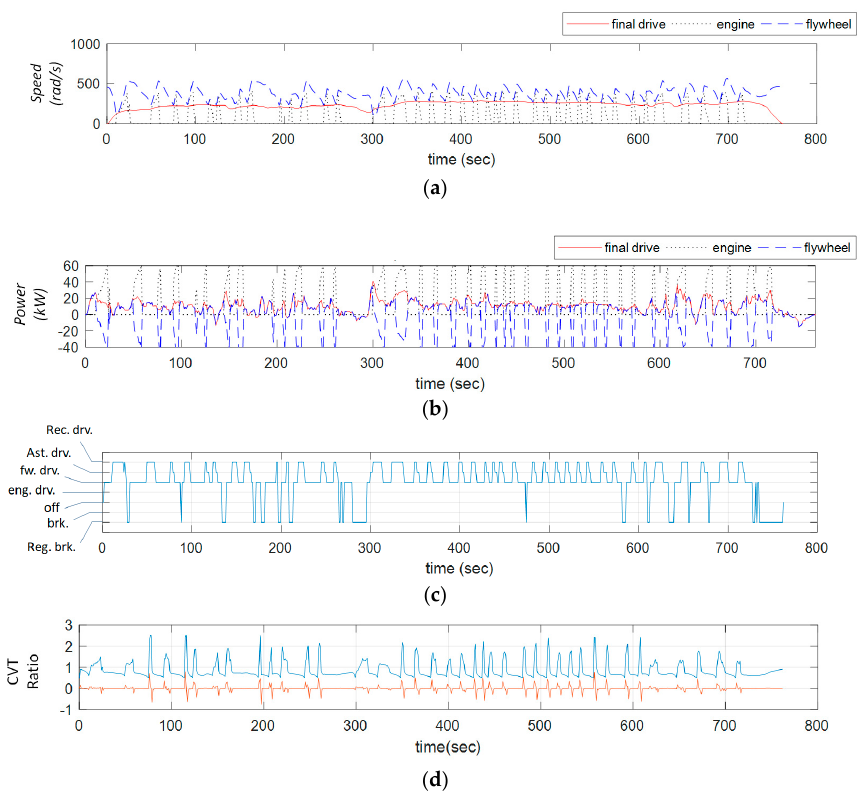
Figure 19. PS-FHV HWFET drive cycle result: ( a ) speed profile; ( b ) power profile; ( c ) driving mode profile; and ( d ) CVT ratio and shift speed